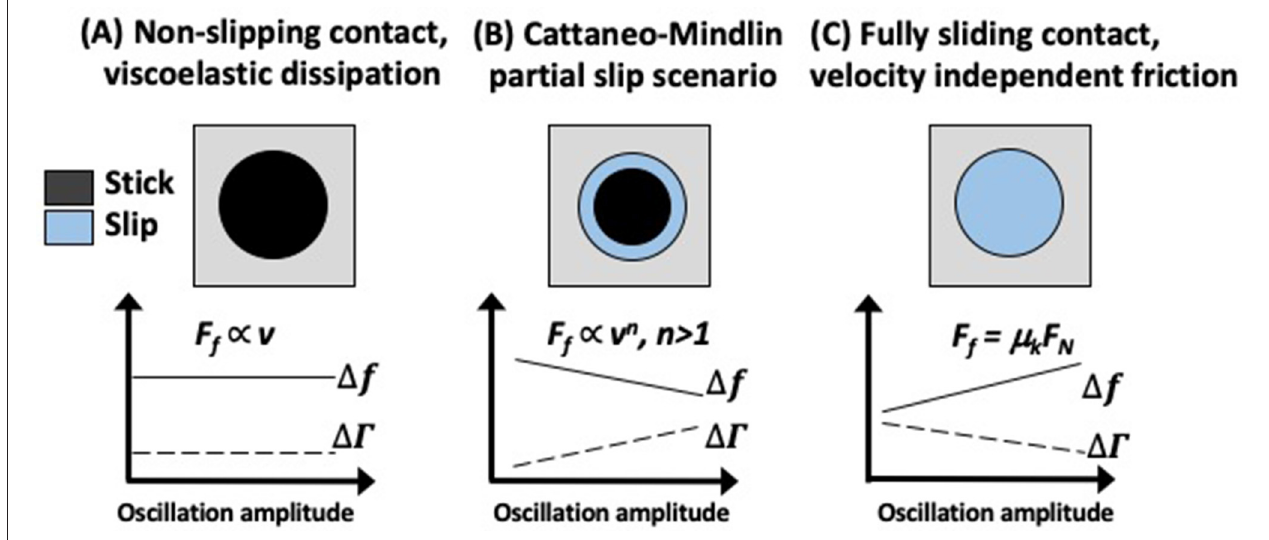
FIGURE 4 | Schematic of the ∆ f and ∆Γ response of a QCM in three distinct idealized continuum contact conditions (A) A non-slipping viscoelastic contact, (B) A partially slipping contact with slipping regions governed by Coulomb friction, and (C) a fully slipping contact governed by Coulomb friction.